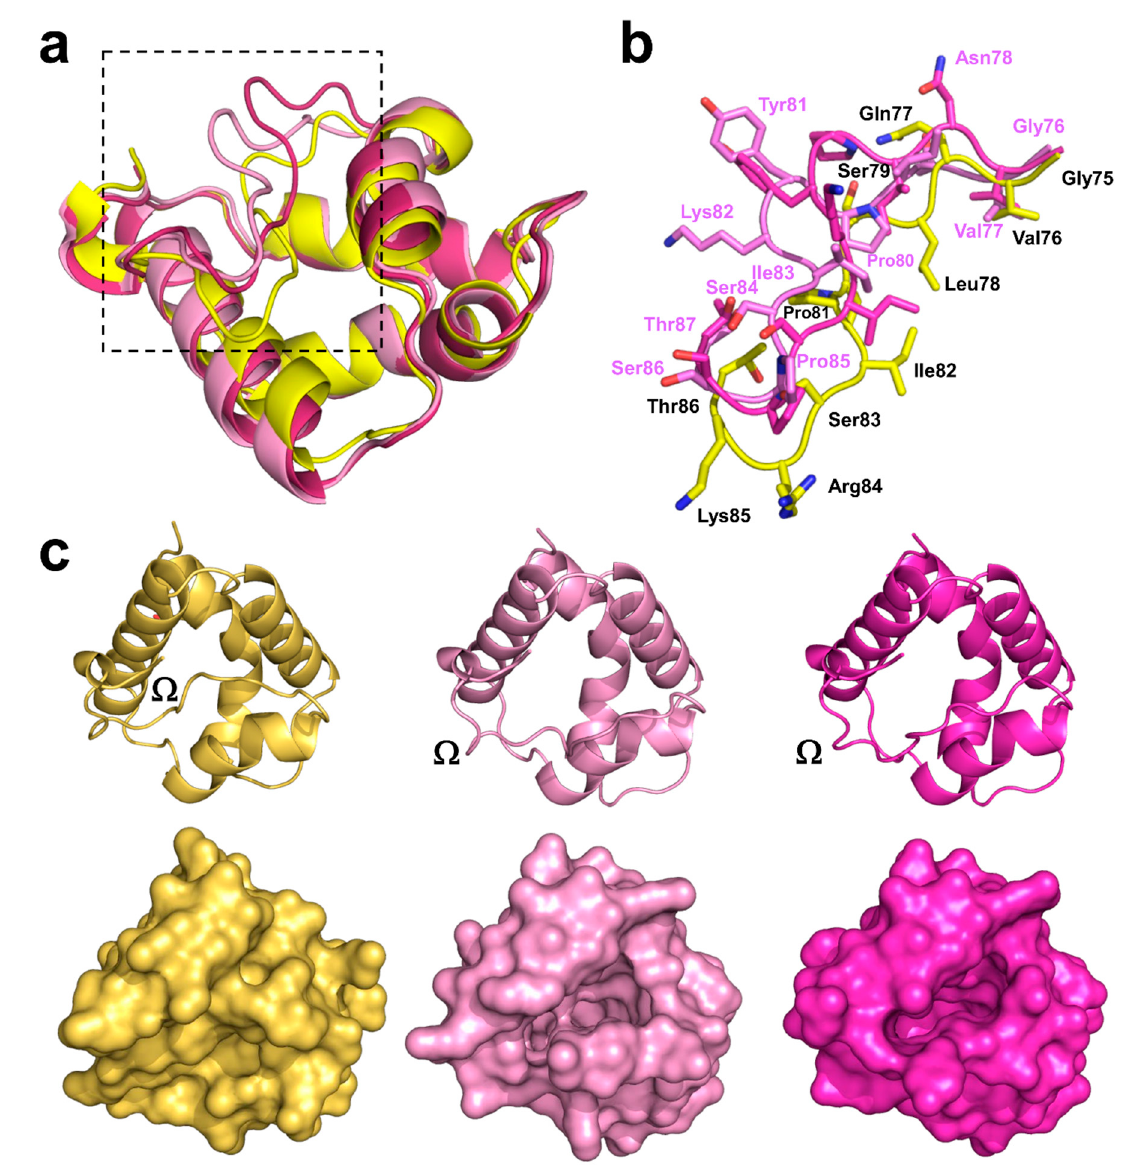
Figure 3 . ( a ) Superposition of Act c 10.0101 and Pun g 1.0101 models shown in cartoon representation. Act c 10.0101 is shown in yellow, while Pun g 1.0101 models corresponding to two different conformations of the molecules are presented in different shades of pink. Regions of the proteins showing the biggest changes in conformation correspond to the Ω loops and were marked with the black square. (b) Close-up view of the Ω loops. Residues from Act c 10.0101 are marked using black labels, while Pun g 1.0101 residues are labeled in pink. ( c ) Models of Act c 10.0101 and Pun g 1.0101 in cartoon (top) and surface (bottom) representations. The models are shown in an orientation that shows the role of the Ω loops in closing and opening access to the ligand binding cavity.